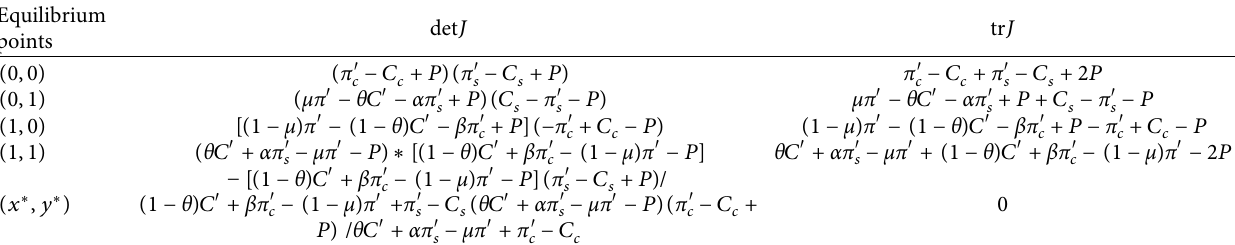
Table 3: Determinant and trace of the Jacobian matrix corresponding to each (possible) equilibrium point. Equilibrium points